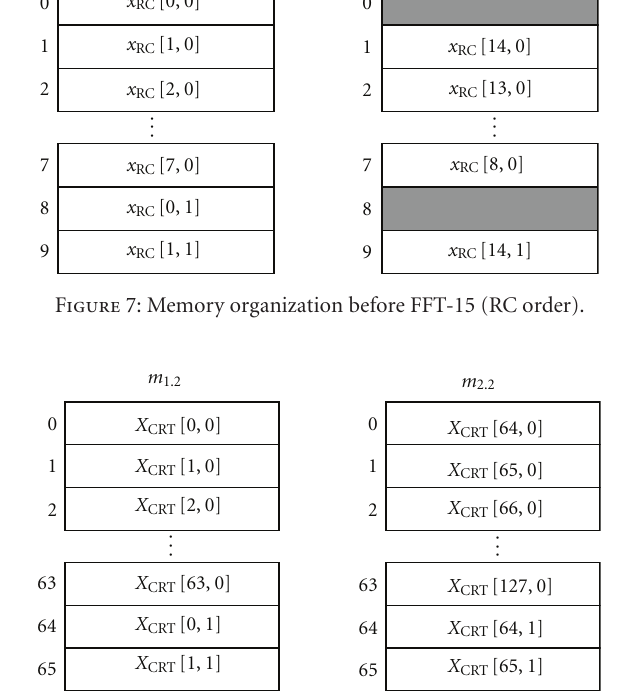
Figure 8: Memory organization after FFT-128 (CRT